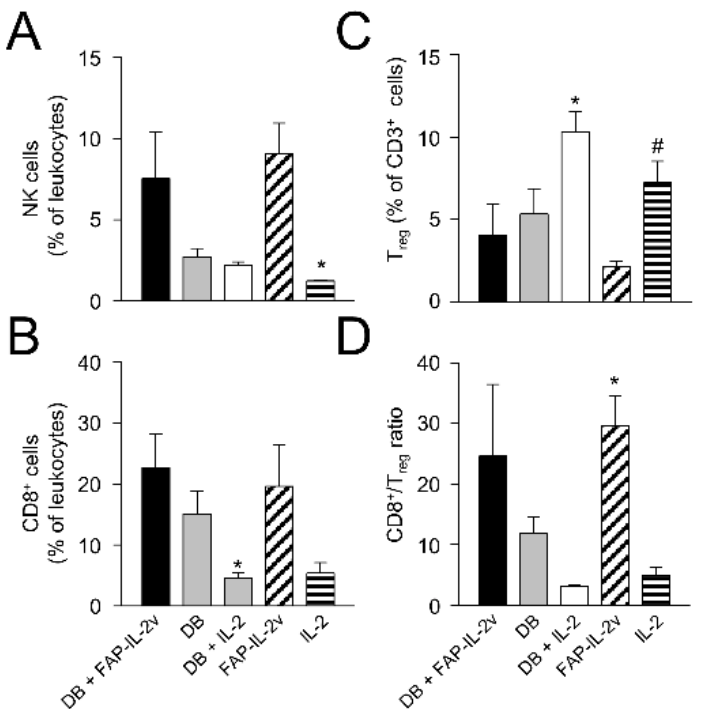
Figure 8. Flow cytometry analysis of tumor-infiltrating lymphocytes. To investigate effects of the combinatorial DB + FAP-IL-2v treatment on tumor-infiltrating lymphocytes, primary tumor tissue was analyzed using flow cytometry. After resection, primary tumor tissue samples were enzymatically digested to obtain a single-cell solution. To assess NK ( A ) and cytotoxic T cells ( B ) as well as Treg ( C ), the effector-cell-population-specific antigens CD335 and CD8 as well as CD25 and FocP3 were marked, respectively. Additionally, the ratio of cytotoxic T cells to Treg ( D ) was calculated. Results are presented as a percentage of the respective effector cell population cells relative to all viable CD45- or CD3-positive leukocytes for NK and cytotoxic T cells or Treg, respectively. ANOVA followed by appropriate post-hoc comparison test and t -test. ( A ) * p < 0.05 vs. FAP-IL-2v, ( B ) * p < 0.05 vs. DB + FAP-IL-2v, ( C ) * p < 0.05 vs. DB + FAP-IL-2v, # p < 0.05 vs. FAP-IL-2v, ( D ) * p < 0.05 vs. IL-2.